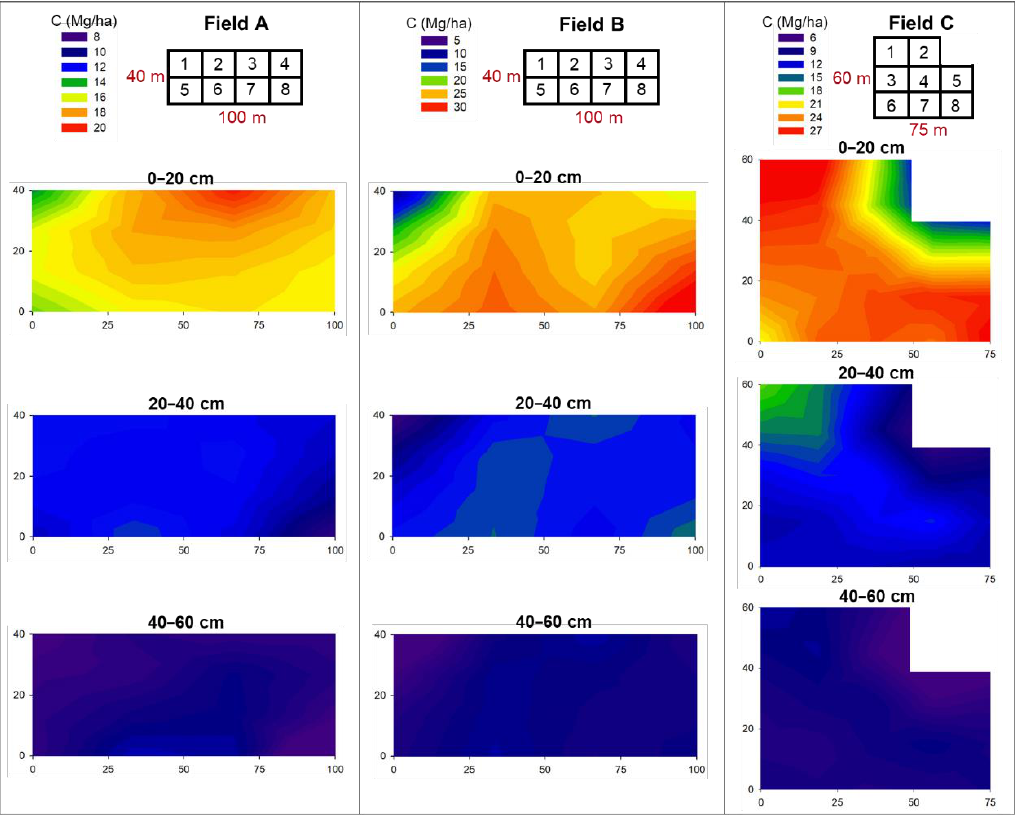
Figure 6. Spatial distribution of soil organic carbon (Mg/ha) stocks (fixed depth interval) in three fields at three depths ( n = 8 grids for each depth and field).